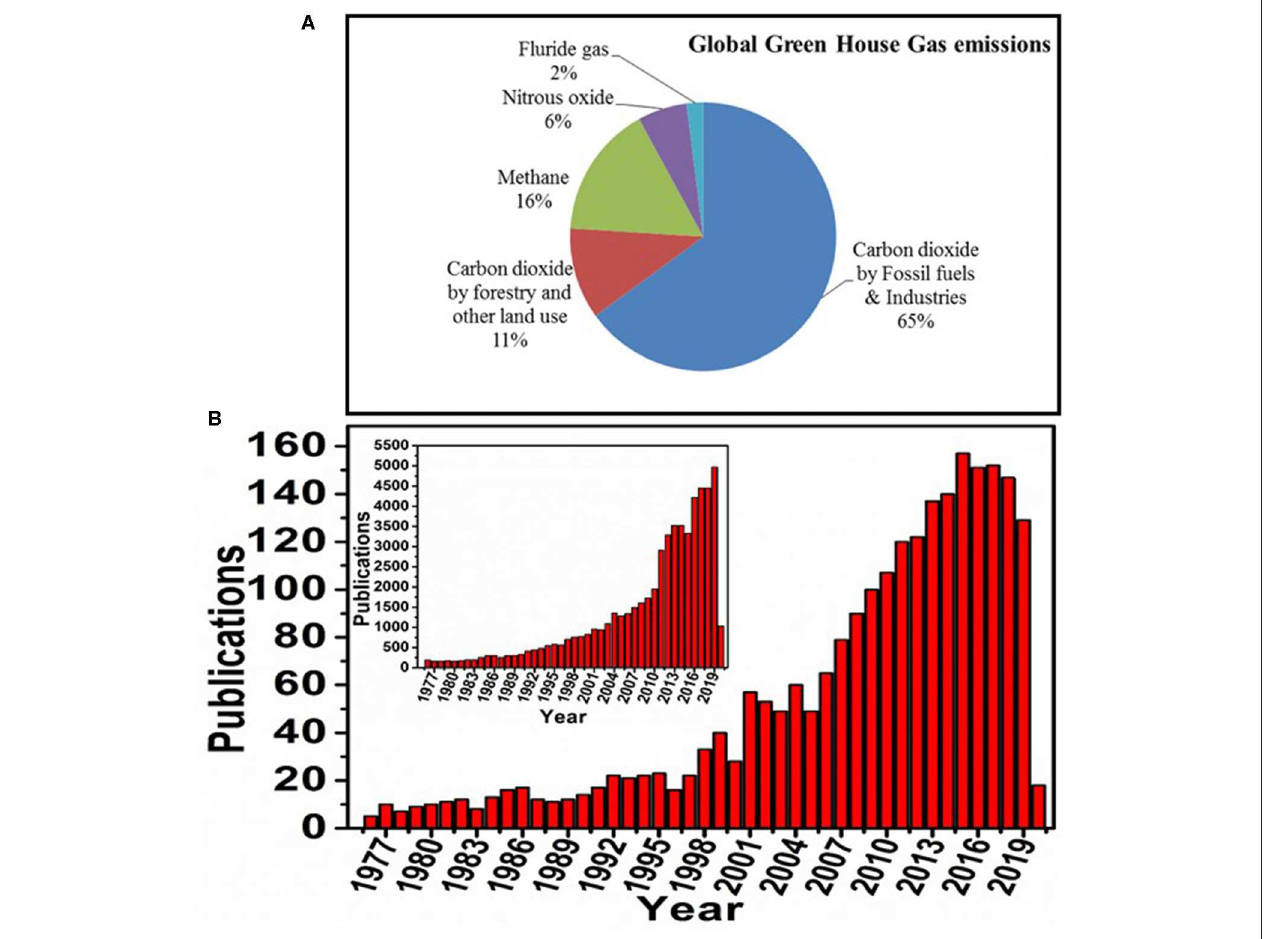
FIGURE 1 | (A) Graphical representation of global greenhouse gas emissions (source: https://tinyurl.com/EPA-GHG-Data), (B) number of articles published on biological conversion of CO 2 to value-added production (source: Scopus; key words: Biological carbon dioxide reduction or Biological carbon dioxide conversion, as on date: 21/04/2020). Inset figure exhibits the number of published articles on carbon dioxide reduction or carbon dioxide conversion irrespective of